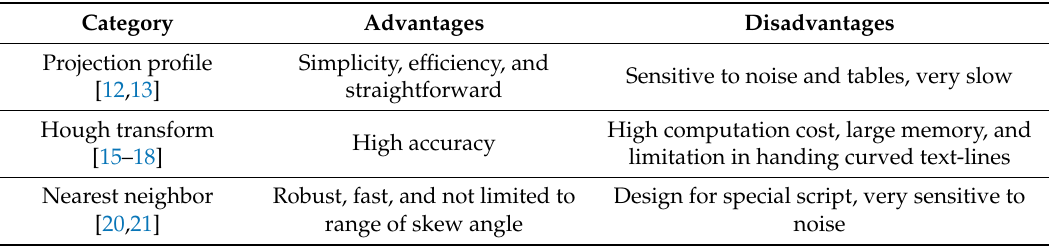
Table 1. Skew angle detection methods for